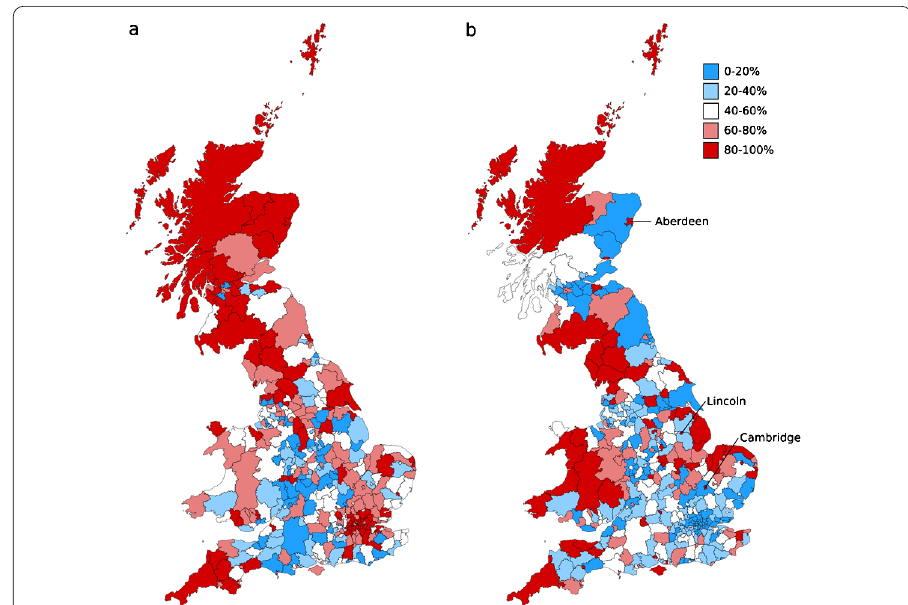
Figure 3 Absolute error in the estimated outward commuting distributions. (a) 1-parameter radiation model. (b) Twitter model ( λ = 0.90). Color: quintiles for the combined set of errors from both